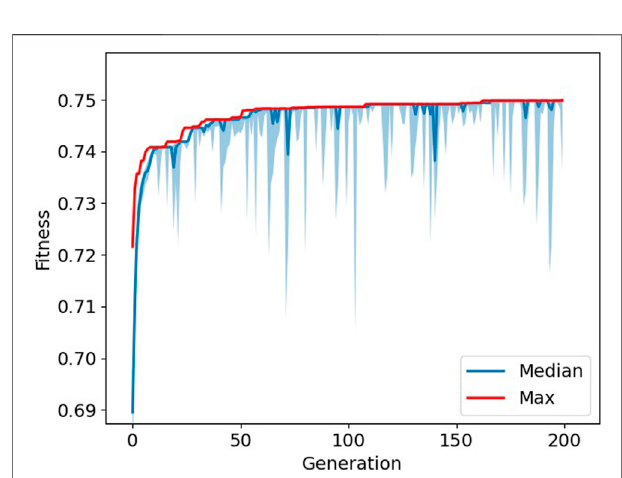
FIGURE 2 | Progression of fi tness during optimization. The maximum fi tness is depicted in red, and the median fi tness with interquartile ranges is depicted in blue. The larger “ spikes ” in the interquartile range show where the GA introduced new random samples to the population.